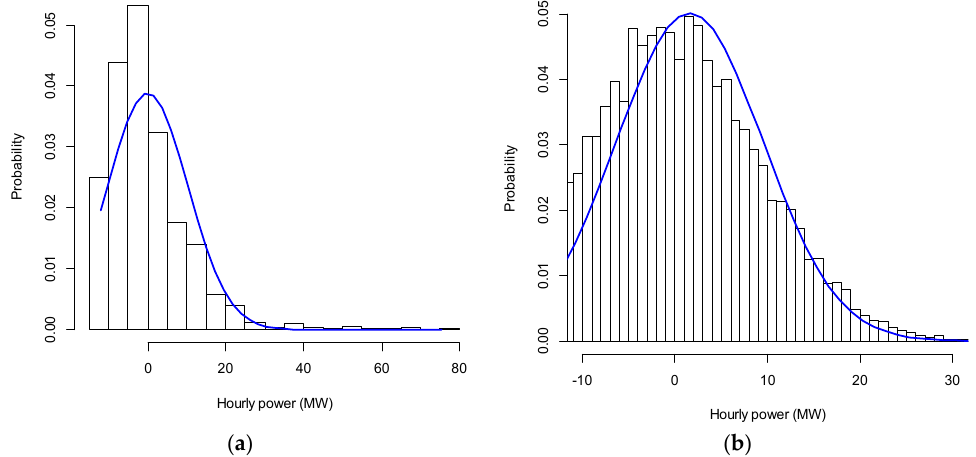
Figure 9. Histogram and pdf of a hybrid wind/wave system generated energy from 3 ‐ h to one ‐ week data.